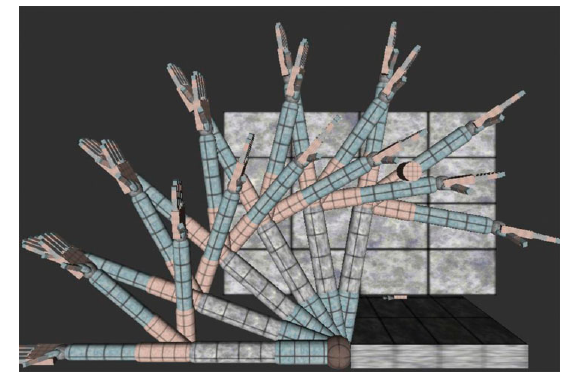
Figure 4. The 18 initial postures of the arm and of the hand used during the 18 corresponding trials.